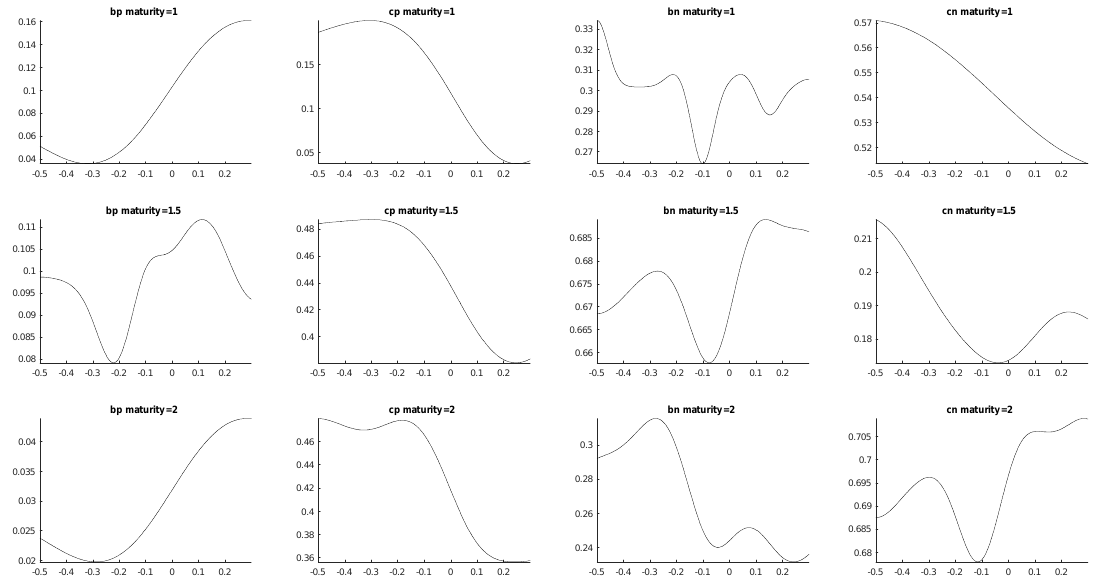
Figure 11. Estimated dependence of the four bilateral gamma parameters on moneyness for the last three maturities.